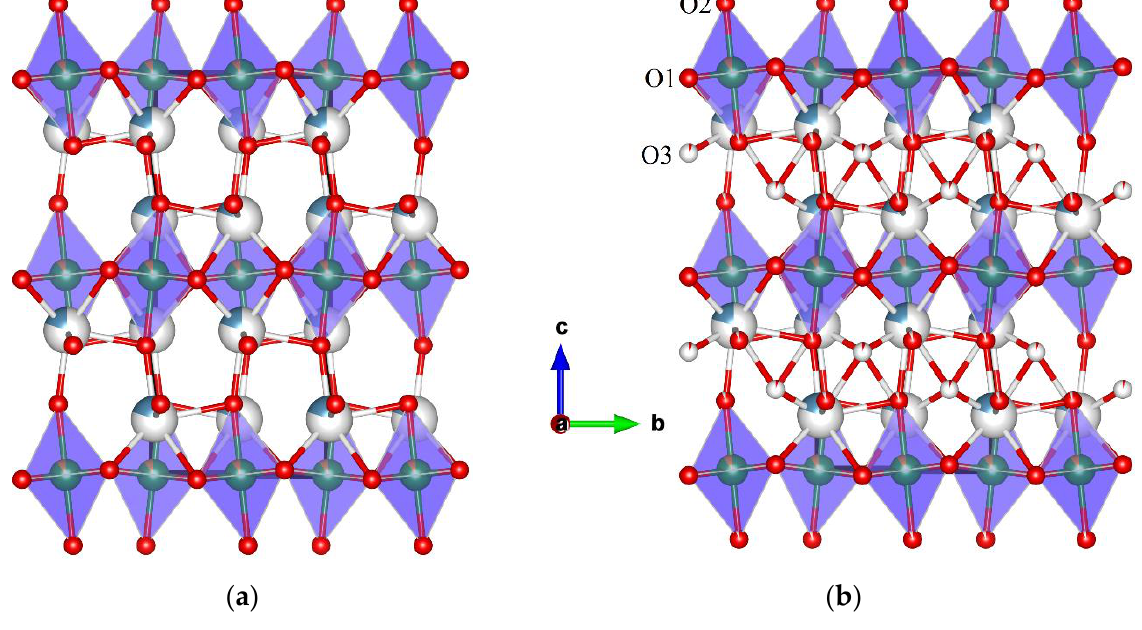
Figure 1. Visualization of the structure (obtained using a software package VESTA [70]) with struc- tural parameters presented in Table 1: the NCNCO01 sample after the synthesis ( a ); the NCNCO01 sample after the high-temperature treatment in static air ( b ). In the picture, the oxygen atoms are presented in red, Ni/Cu in green (with orange parts), and Nd/Ca in white (with blue parts). Partial coloring of the atoms represents partial occupancies of the site. Table 2. Results of the Rietveld refinement of the NCNCO03 structure obtained at 50 ◦ C by TOF